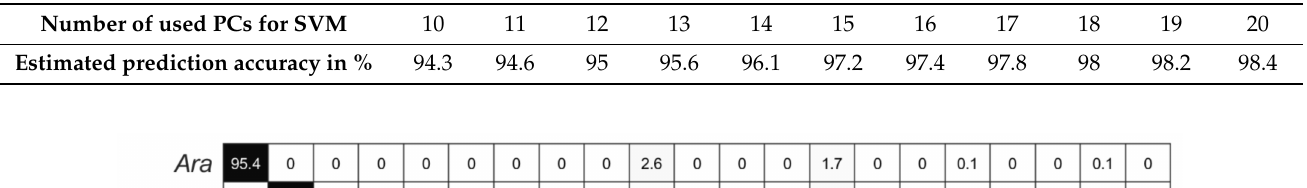
Table 2. Number of used PCs for SVM models and estimated prediction accuracy by five-fold cross-validation.